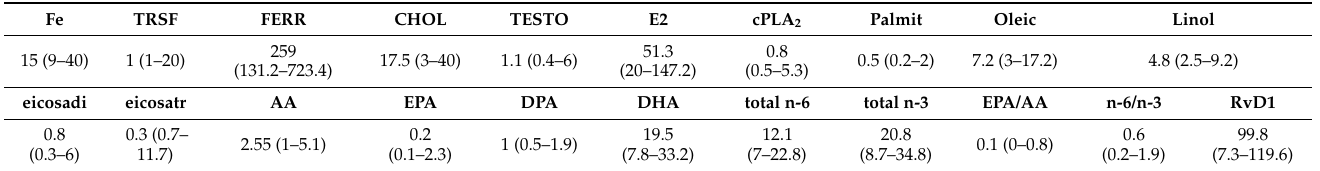
Table 4. Median and Interquartile ranges (IQR) of variables in the group of 20 men (6 fertile men, 14 infertile: 8 with varicocele, 6 with leukocytospermia).